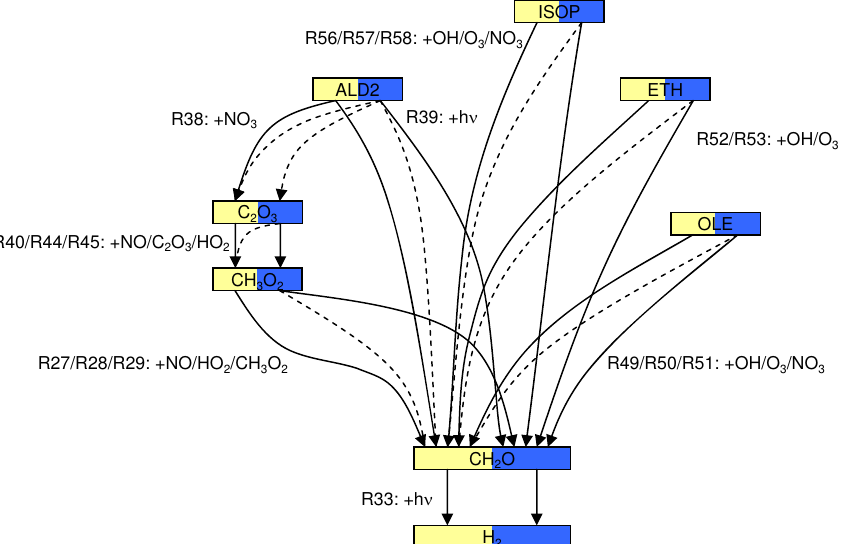
Fig. B1. NMHC reactions modified for hydrogen isotope chemistry. Yellow container species are non-deuterated, whereas blue containers species are singly deuterated species. The solid lines indicate production of the species from the reactant species that is taken into account, whereas the dashed lines indicate production that is neglected (as explained in Sect.